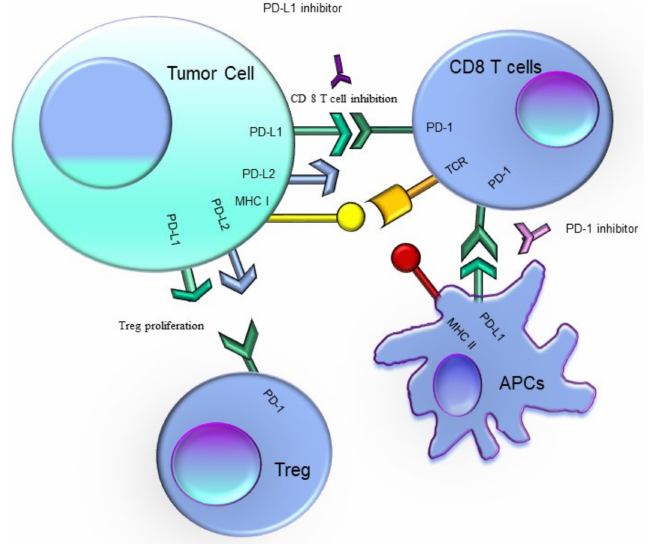
Figure 1. PD-1–PD-L1/2 pathway mechanism in cancer and under physiologic